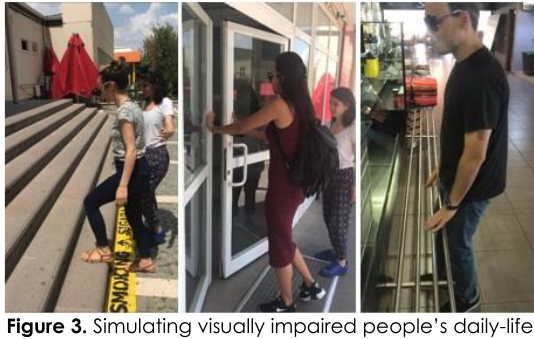
Figure 3. Simulating visually impaired people’s daily -life activities in the café